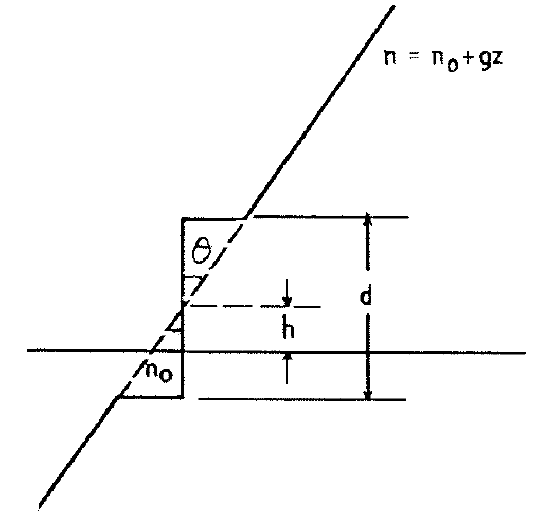
Fig. 10. Sketch of a turbulent layer (Woodman and Rastogi, 1984).